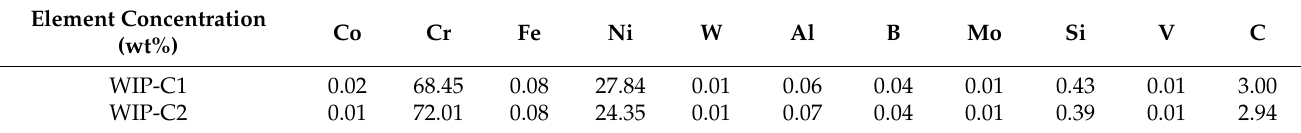
Figure 2. BSE image of WIP-C2 powder. Table 2. Composition of WIP powders.